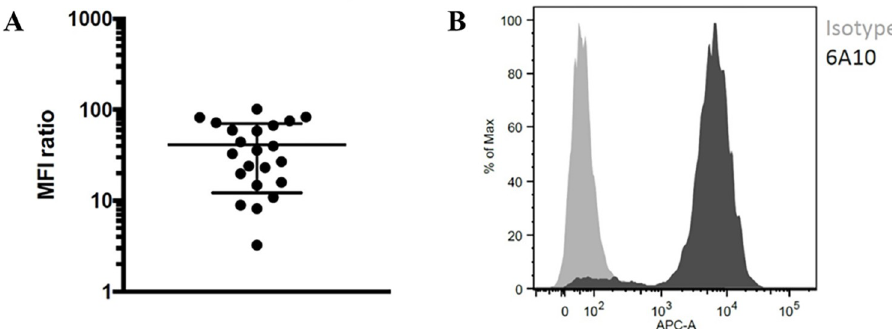
Fig 3. Detection of CA XII by flow cytometry. (A) Quantity of CA XII expression on vital, adherent OC cells in ascites samples. (B) Representative histogram of fluorescence measurement.